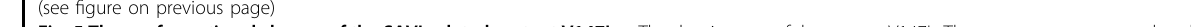
Fig. 5 The conformational change of the SAVI-related mutant V147L. a The density map of the mutant V147L. The two monomers are colored in green and blue, respectively. b A ribbon representation of the mutant V147L. The two monomers are colored as in a . c Structural alignments of the apo STING (PDB 6NT5, grey), the HB3089-bound STING (this study, red), and STING mutant V147L (this study, blue and green). The proteins are displayed in ribbon. The HB3089 is in stick. d A top of the red boxed region in c , showing the LBD of the mutant is slightly less contracted than that of the HB3089-bound form. e The inter-C α distance between residues His185 at LBD α 1 of the mutant V147L. f Side (left) and top (right) view of the connector from HB3089-bound STING, showing the two monomers of the connector and the LBD α 1 form the right-handed crossover. The map and model are in transparent surface and ribbon, respectively. Side view ( g ) and top ( h ) view of the orange boxed region in c , showing the helices and the loops of the connector from the mutant (green and blue) revolved (curved arrows) and moved downwards (arrows), respectively. The residues 147 are indicated by side chain showing. i The inter-C α distance between residues Leu147 at the connector of the mutant V147L. j A top view of the boxed region in c . The conformational changes of the TMD of the mutant is essentially identical to that of the HB3089-bound form as describe in Fig. 2b. The side ( k ) and top ( l ) views of the boxed view in c , showing that the TM1 revolved on its own axis as compared that of the apo STING. It shows that the TM1 of the mutant V147L revolved on its own axis, which is similar to that of agonist-bound STING. For clarify, only the TM1 and TM4 are